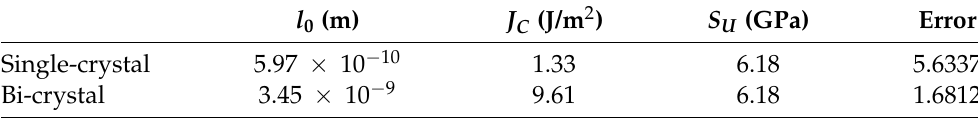
Table 2. Fracture toughness estimation based on virial stress